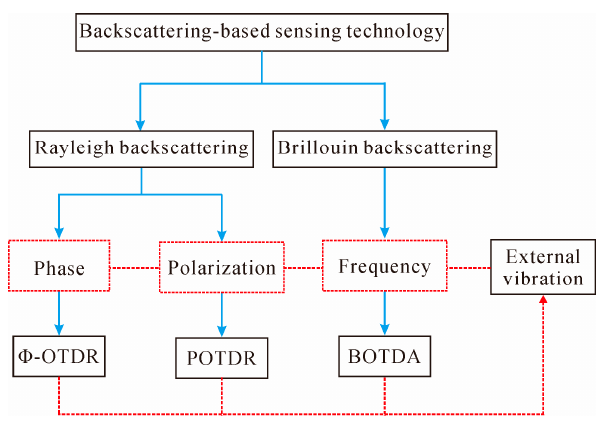
Figure 7. Schematic diagram of the detection principle of backscattering-based vibration sensors.